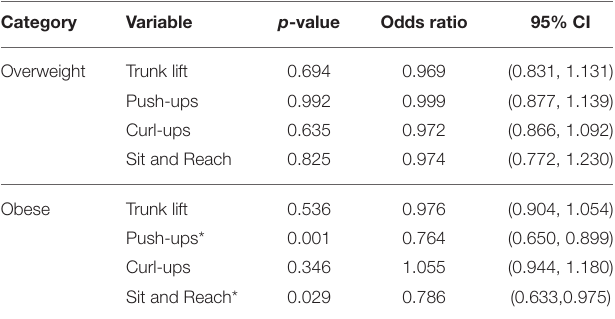
TABLE 8A | Associations between musculoskeletal fitness and weight status in third through fifth grades (reference group: healthy weight). Category Variable Overweight